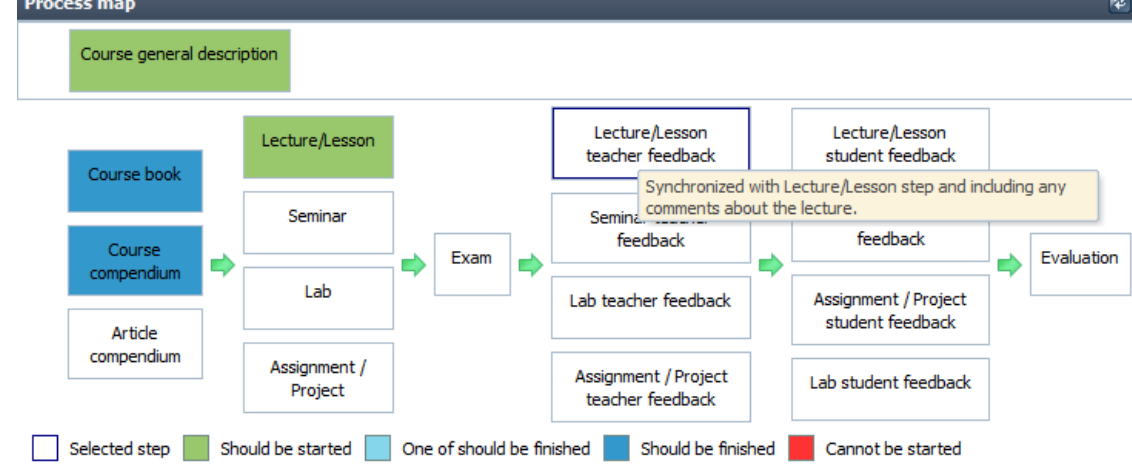
Figure A8. The process map of course preparation in the form suitable for discussion with